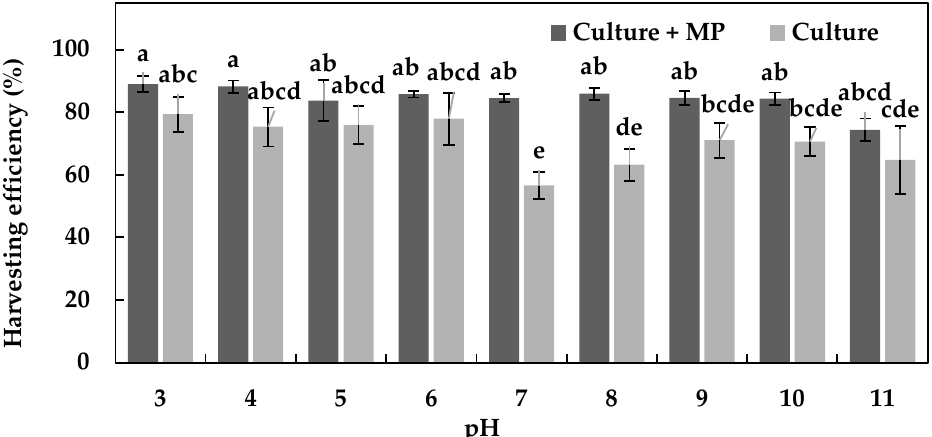
Figure 2. Effect of different pH values on the harvesting efficiency of a mixed culture of Desmodesmus sp. and C. vulgaris (500 mg L − 1 ) with (Culture + MP) and without (Culture) MP after a 60-min sedimentation time (seed powder concentration: 500 mg L − 1 ). Different letters indicate significant differences between the pH values after a one-way ANOVA followed by a Tukey test ( p < 0.05). The rotation speed and time used were 150 rpm for 5 min, followed by 70 rpm for 20 min in an orbital shaker. Columns represent the average values, and error bars represent the standard deviations of triplicates .